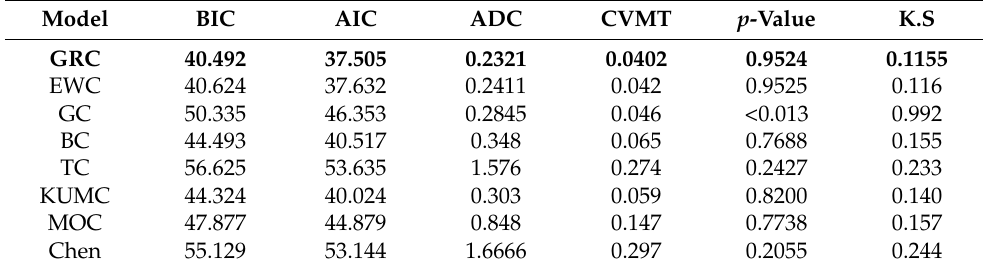
Table 1. Comparing results using the relief data set.